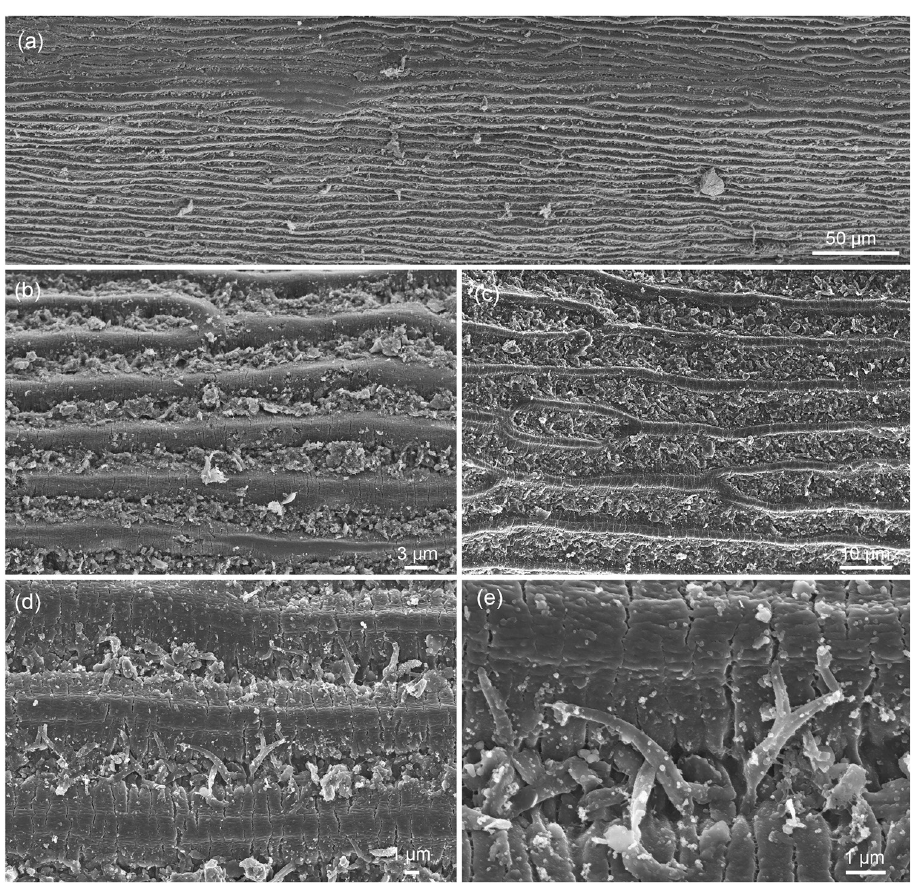
Figure 1. Beatogordius nagalandis sp. n., cuticular pattern: a cuticular pattern at lower magnification b, c branching and fusion of “bands”, space between bands is filled with debris d, e spines are present between the bands, fine cracks structure the bands stronger (d) or weaker (e) into subunits. Host.